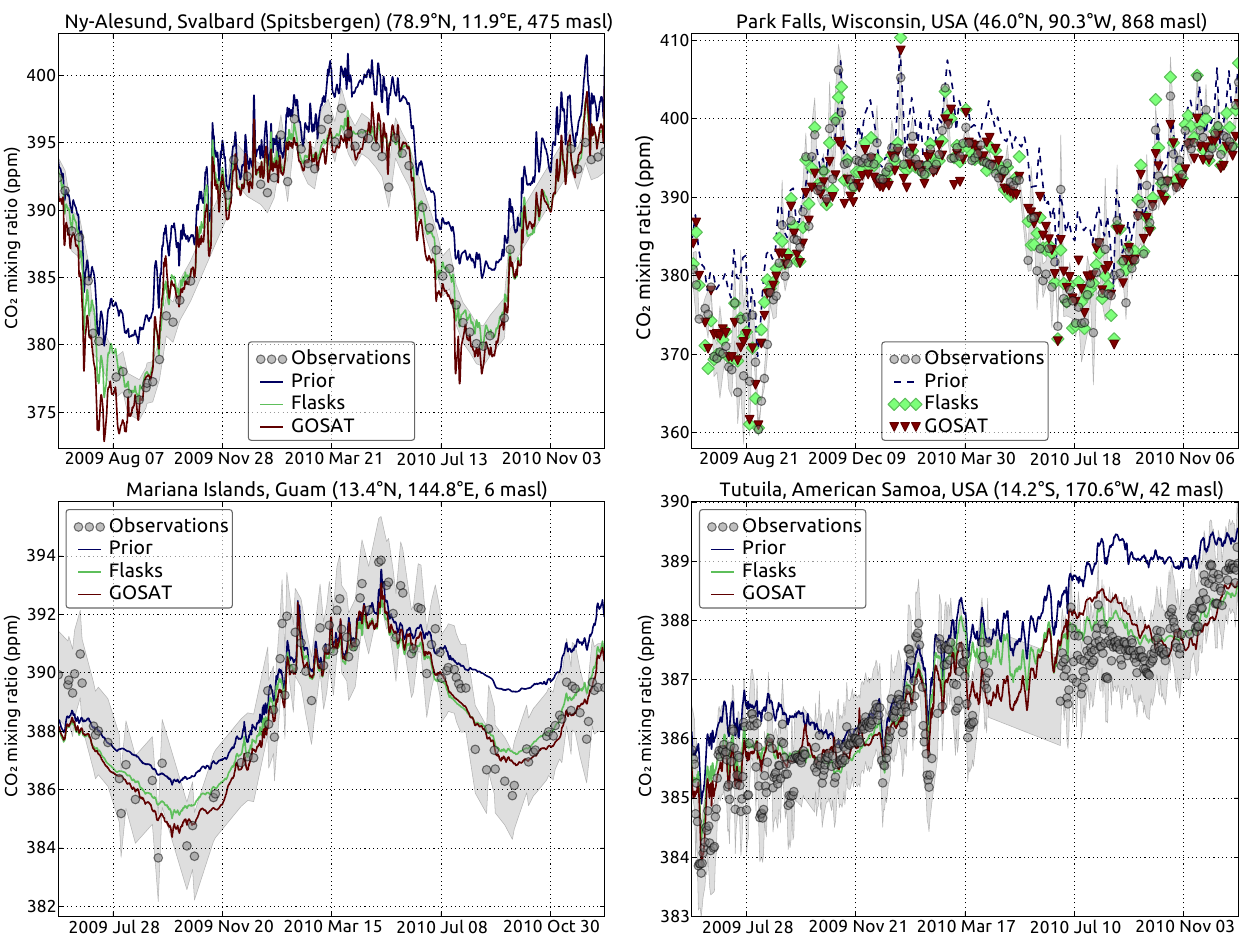
Fig. 3. Model estimated CO 2 time series at four surface stations in the tropics and northern extra-tropics, compared to CO 2 measurements taken at those stations. The “GOSAT” line is from an inversion using only GOSAT X CO , whereas the “Flasks” line is from an inversion 2 using only surface samples. At Park Falls, to prevent the large diurnal cycle in the continuous time series from obscuring the picture, the model has been presented after being co-sampled at observation times and averaged over three-day windows. This is purely for visual